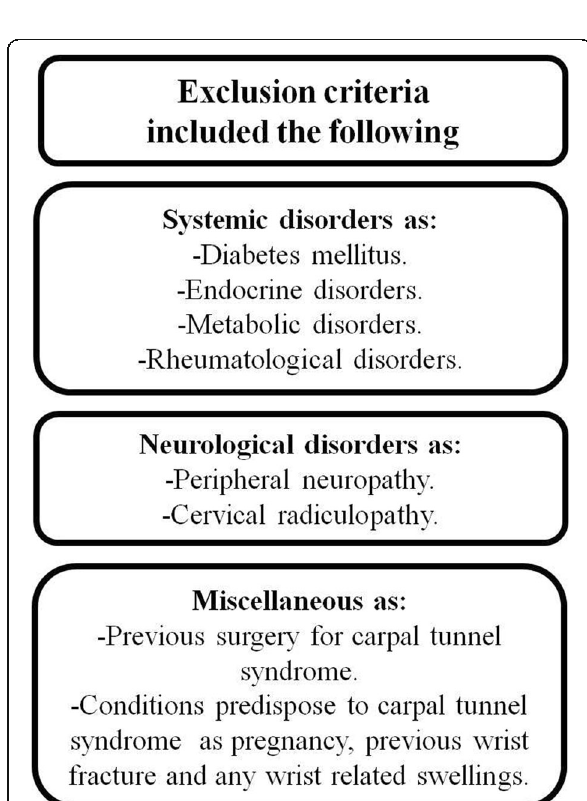
Fig. 3 Exclusion criteria of the study [14, 16,